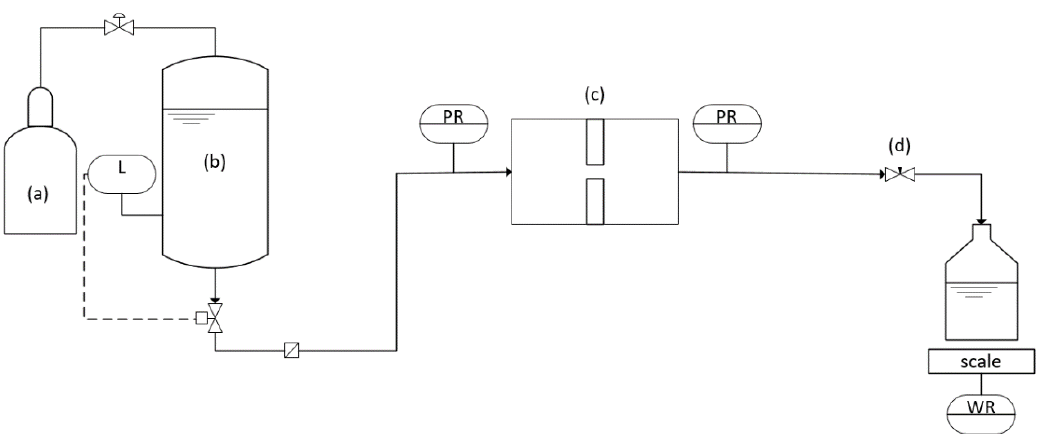
Figure 1. Experimental setup of the original scale system ( Ψ = 1) with pressurized gas cylinder ( a ), pressure vessel ( b ), optically accessible orifice ( c ) and needle valve ( d ). The level of the pressure vessel (L) is measured constantly to avoid a complete emptying. The values of the pressure sensors (PR) and the scale (WR) are recorded during the experiment.